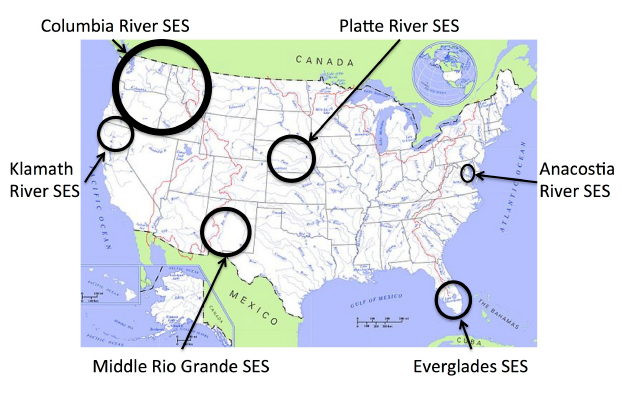
Fig. 1 . Location of riverine and wetland